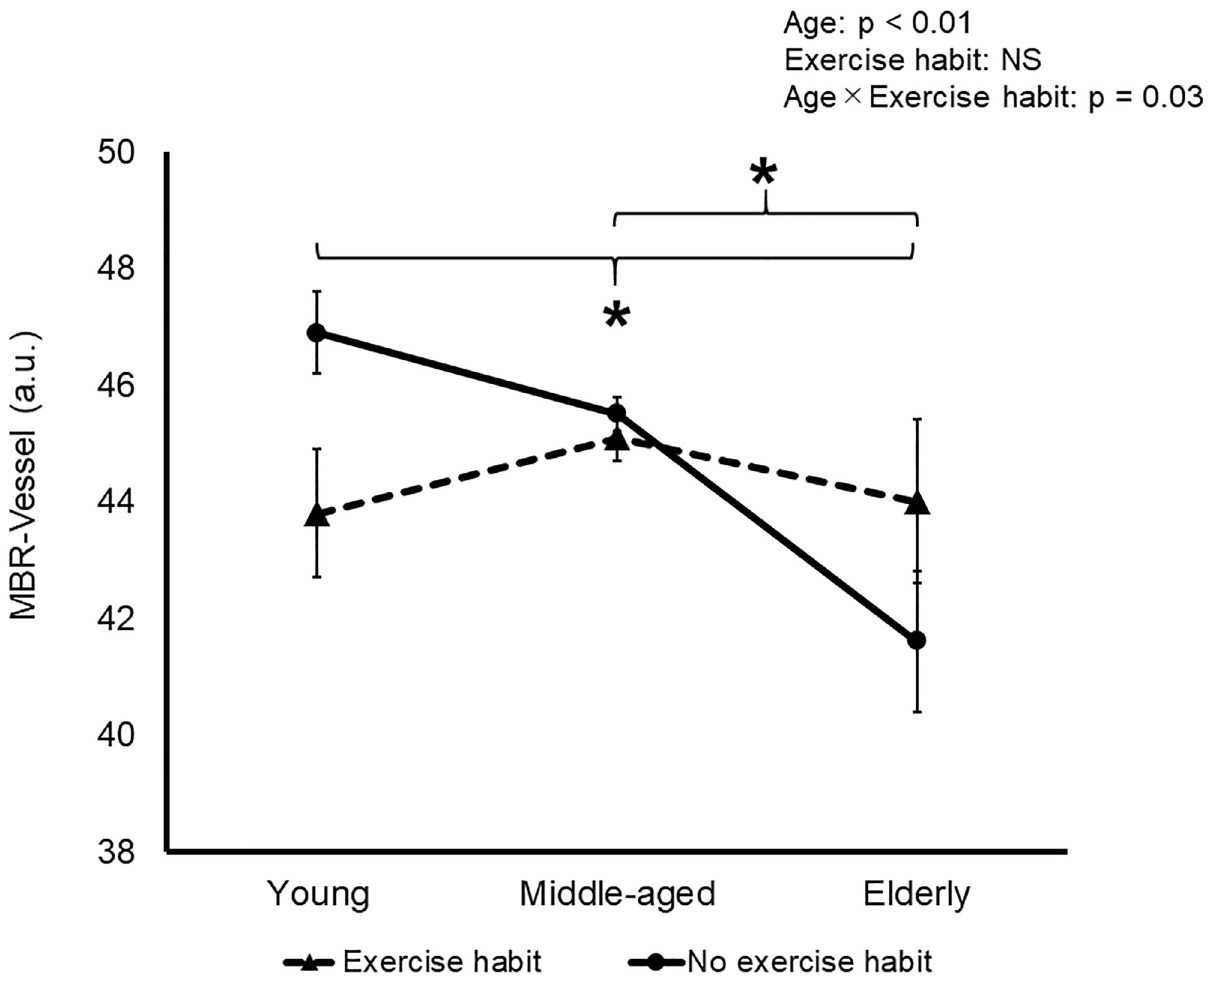
Fig 1. Effects of aging and self-reported exercise habits on MBR-Vessel. � , significant difference among young ( < 40 years old), middle-aged (41–64) and elderly ( > 65) groups without exercise habits; †, significant difference between groups without exercise habits. Data are mean and SD.